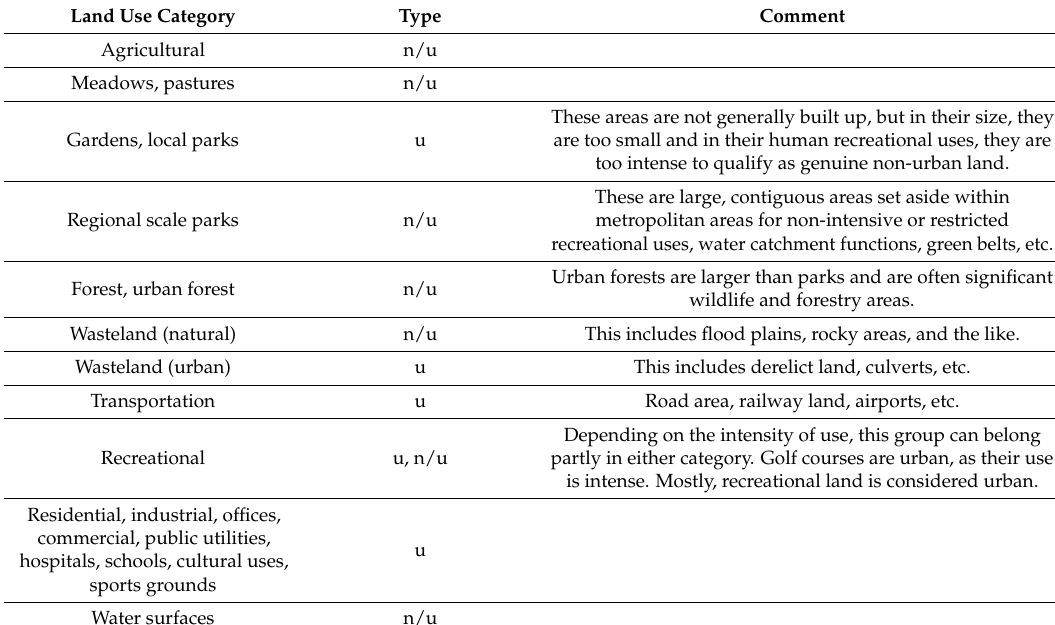
Table 3. Urban land definition (Item 2, Table